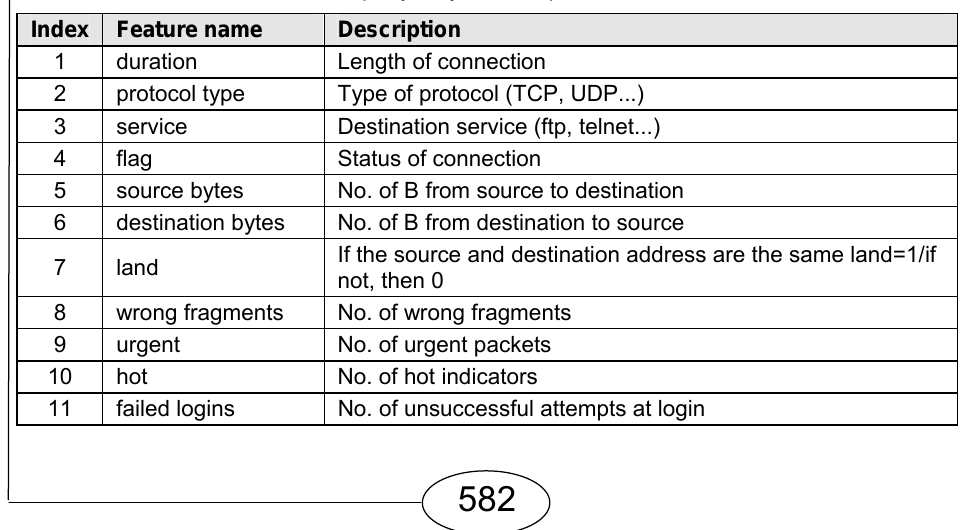
Table 1 – Features in the KDD Cup ‘99